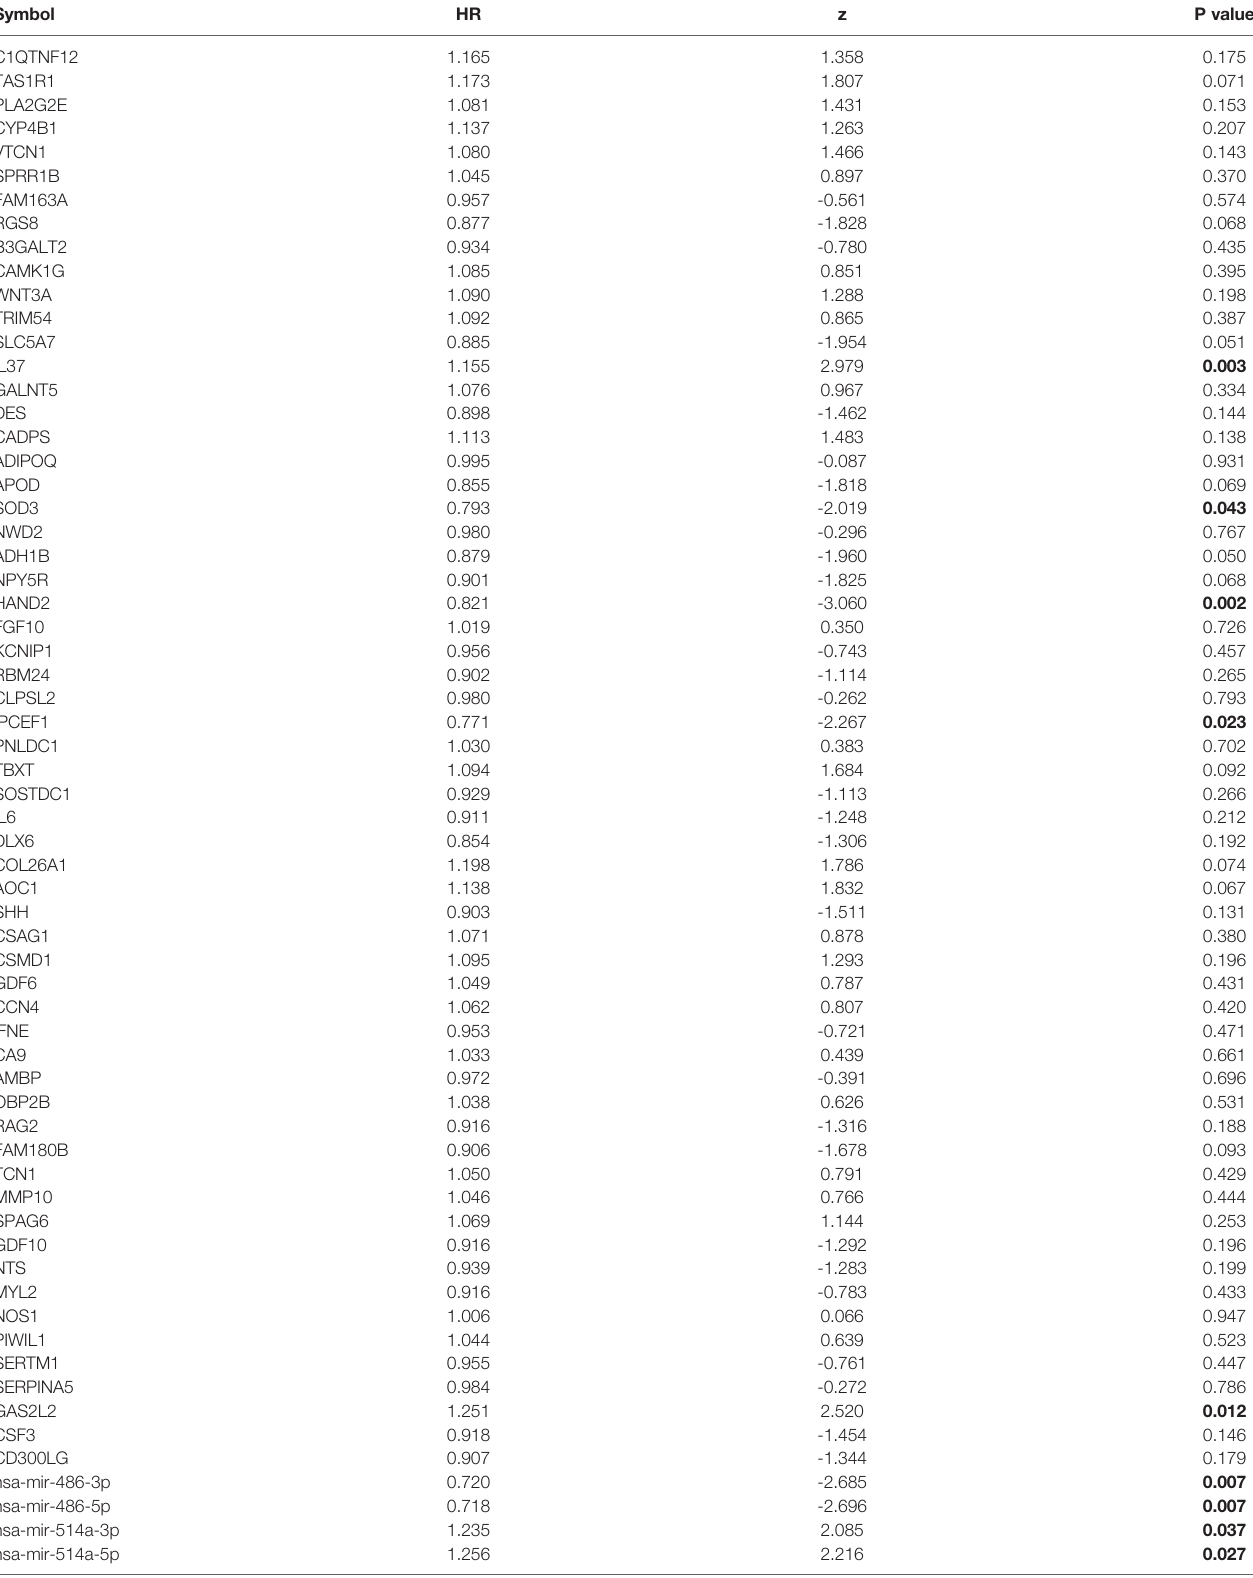
Bold values indicate that the P value is less than